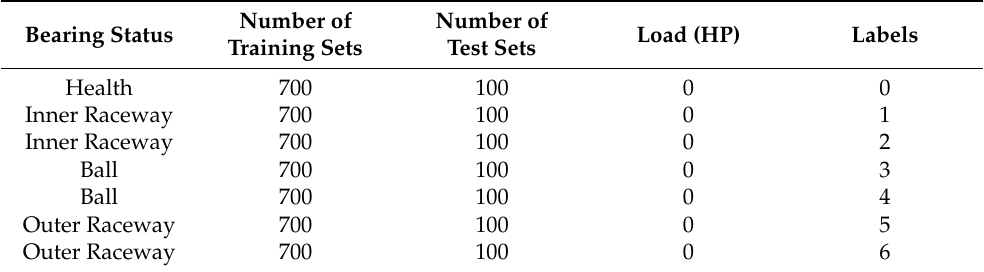
Table 12. Details of data set 2.